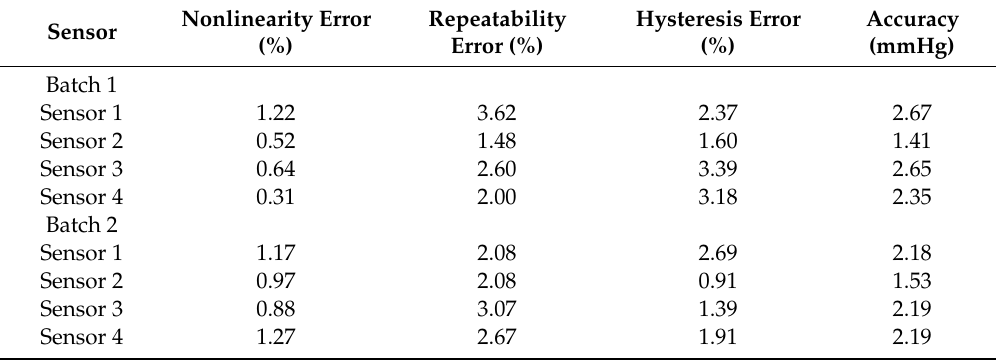
Table 3. Repeatability and non-linearity error (%) for AMI air-pack sensors of batch 1 and 2.